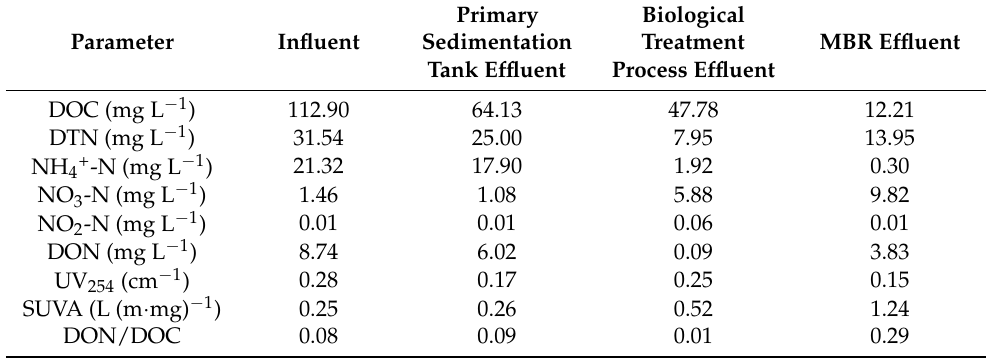
Table 1. Water quality indexes of influent and effluent of main sewage treatment unit in WWTP.